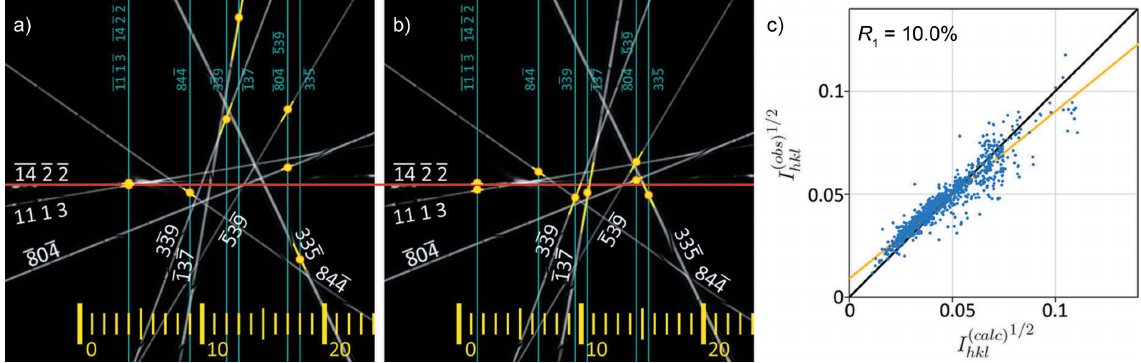
Figure 8 ( a ) The intersections with Bragg conditions for eight reflections in the first Si Felix simulation. Frame numbers are given at the bottom of the image and the frame in which each peak intensity is found is marked by a vertical blue line. The intersection of the blue line with its Bragg condition is marked by a yellow dot (yellow lines correspond to an error of (cid:10) 0.5 frames). The horizontal red line marks the nominal beam path (output from PETS ) and if the crystal orientation was correct the yellow dots would all lie on this line. ( b ) The best fit to a straight line is obtained by shifting the blue lines by (cid:7) 2.5 frames. ( c ) R 1 calculation using an optimized beam path and a specimen thickness of 185 nm. R 1 = 10.0%